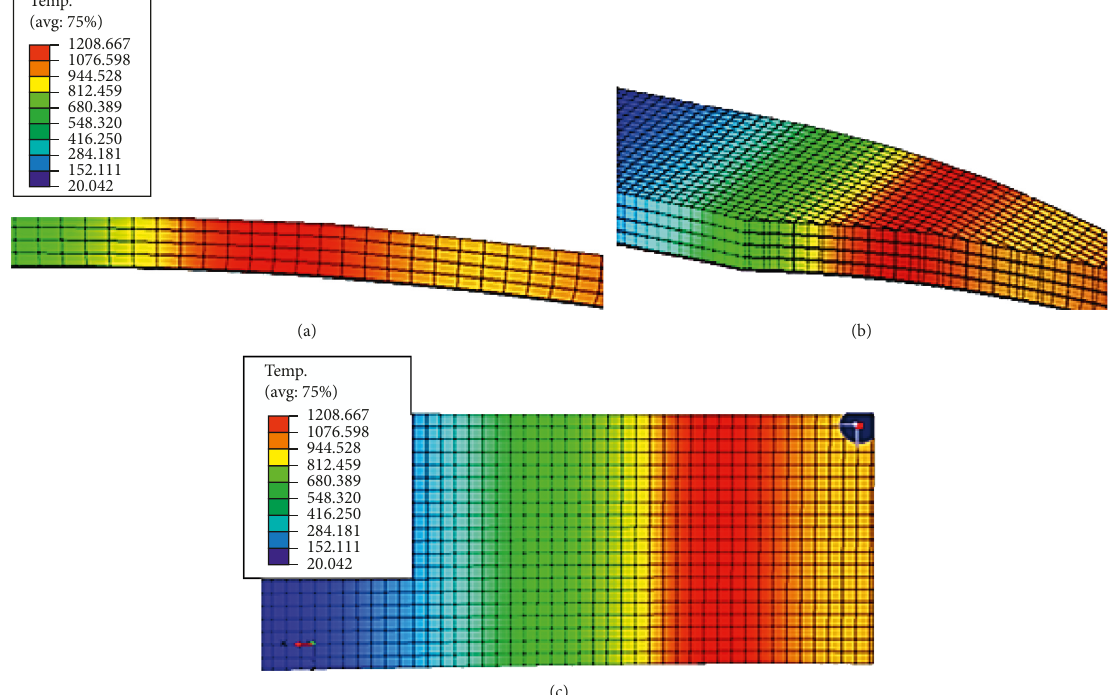
Figure 5: General view of the temperature field of a steel tape in the thermal deformation hearth (a, b) and the distribution of thermal fields in the zone of tape contact with the surface of the part (c) in the electrocontact surfacing at t imp �